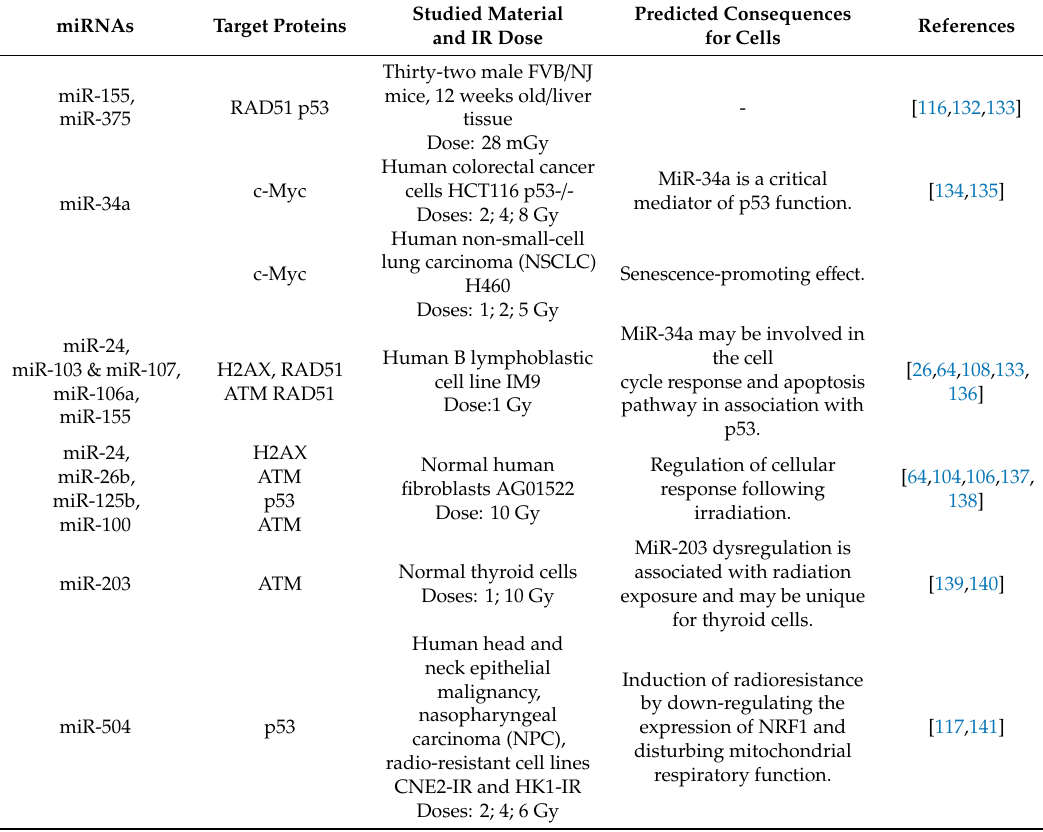
Table 1. MicroRNAs that a ff ect DNA damage response and homologous recombination repair downregulated after